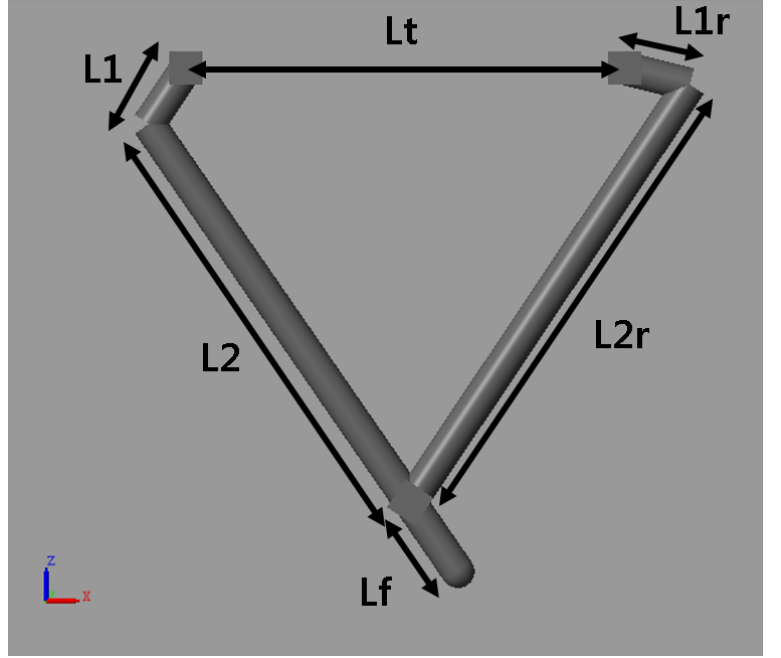
Figure 9. Leg model parameter. Table 2. Leg model parameter